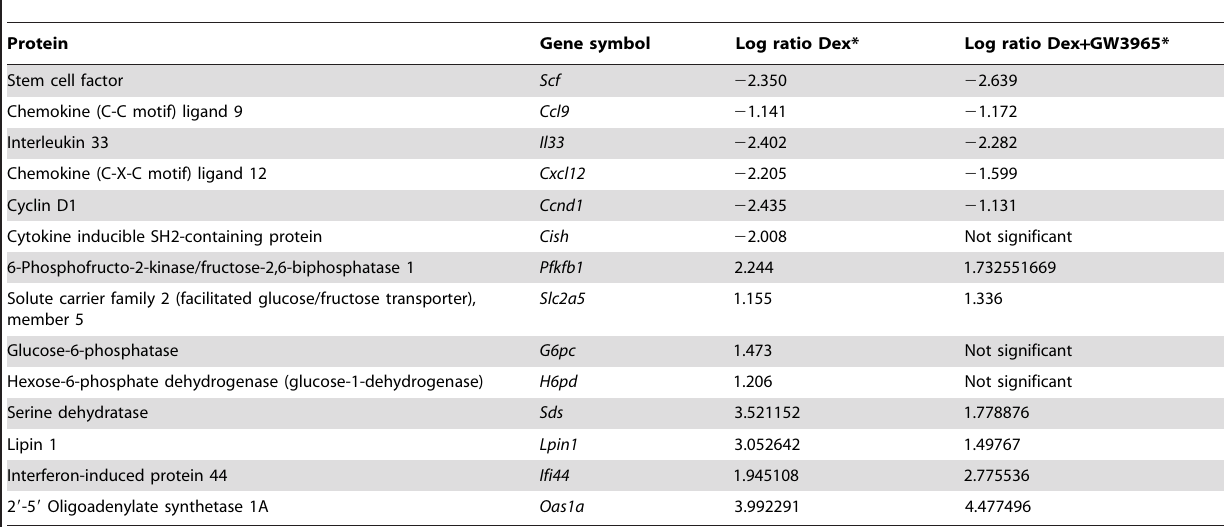
Table 1. mRNA Expression of Selective Glucocorticoid-responsive Genes in the Liver of Rats Treated with Dexamethasone in the Absence or Presence of